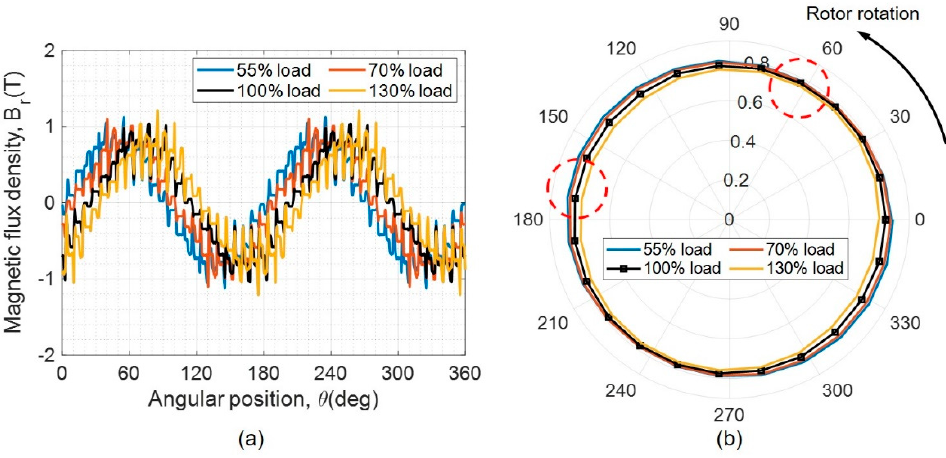
Figure 4. ( a ) The air-gap magnetic flux density and ( b ) the trajectory of the rotating magnetic field.